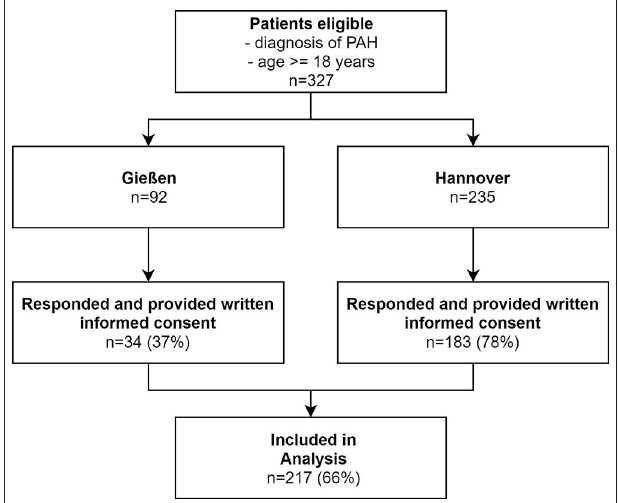
FIGURE 1 | Flowchart of patient